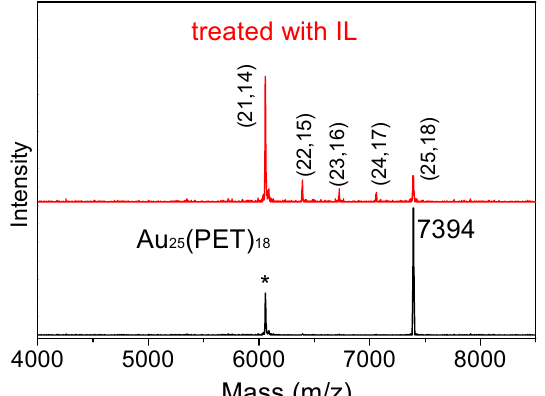
Figure 6. Matrix-assisted laser desorption / ionization mass spectrometry (MALDI-MS) of the fresh Au 25 (PET) 18 clusters and samples treated with the ionic liquid (IL) of BMIM · BF 4 ; the ( n , m ) presents the number of the Au n (PET) m species. Reproduced with permission from [47]. American Chemical Society, 2015.